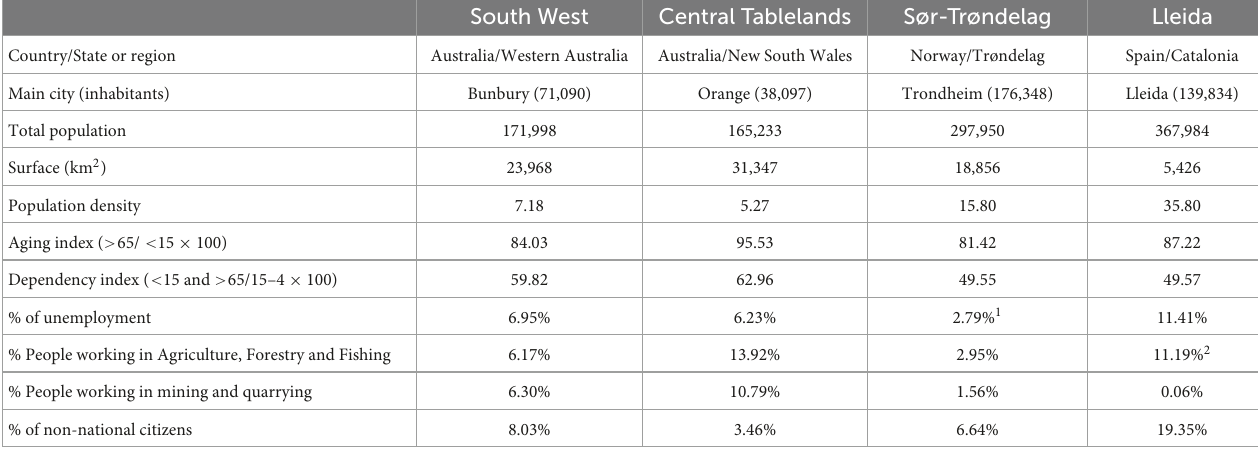
TABLE 1 Demographic and Socioeconomic Indicators of the South West and Central Tablelands (Australia), Sør-Trøndelag (Norway) and Lleida (Spain). South West Central Tablelands